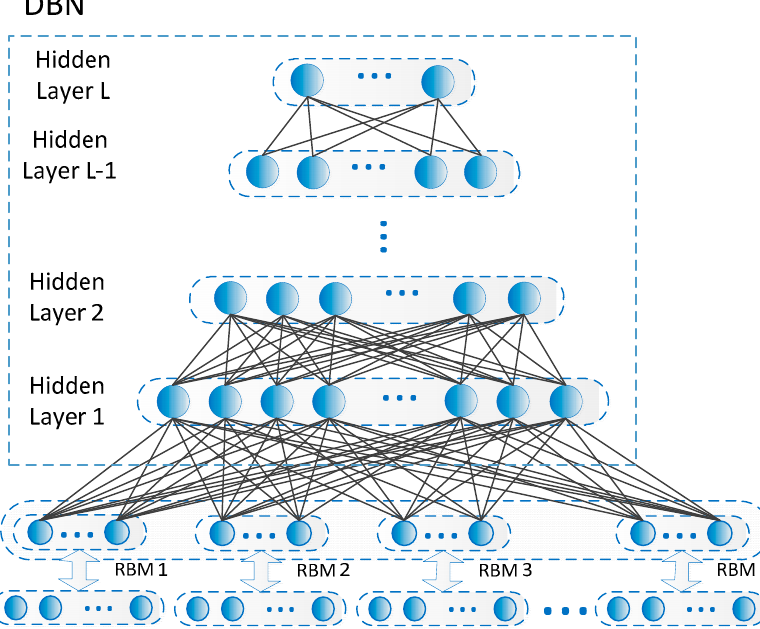
Figure 5. Upper structure design based on DBN.